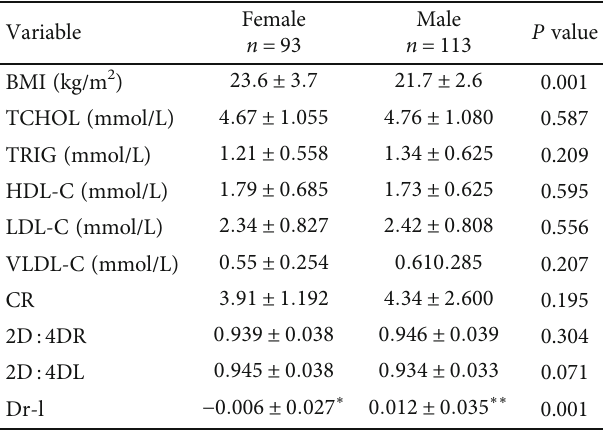
Table 1: General characteristics of the study population. Variable